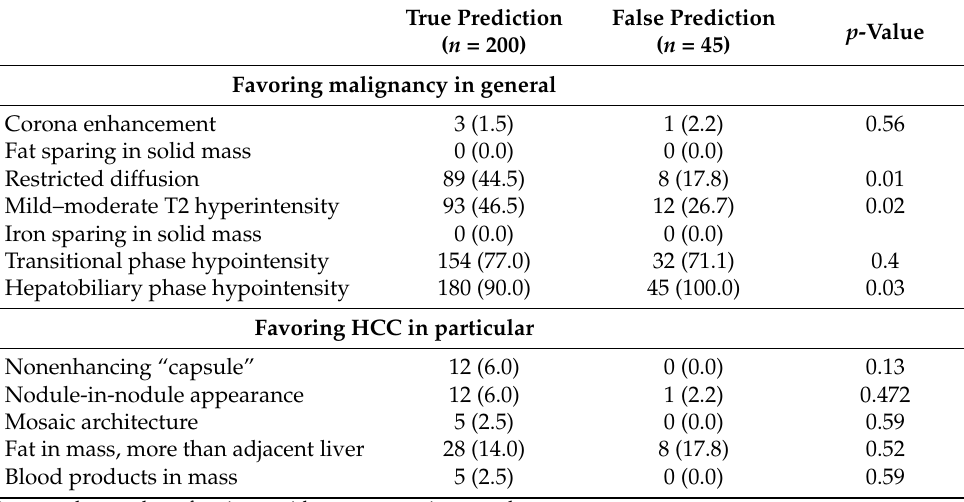
Table A4. Comparison between true prediction and false prediction using decision tree algorithm in development